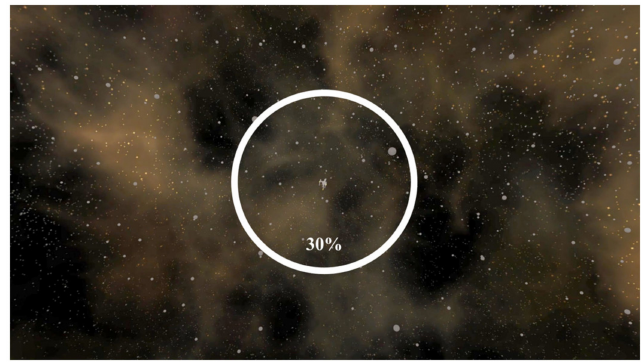
Figure 1. The first VR sickness reduction method (M1). The VG of the second VR sickness reduction method had a size that changes from 0% to 30% that of the aspect ratio, and a position synchronized to the user’s head movement direction. This was a way to temporarily attract the user’s gaze. In other words, as the VG was no longer visible when the size of the VG reached 0%, this allowed users to focus more on the content. Figure 2 shows the second VR sickness reduction method (M2).